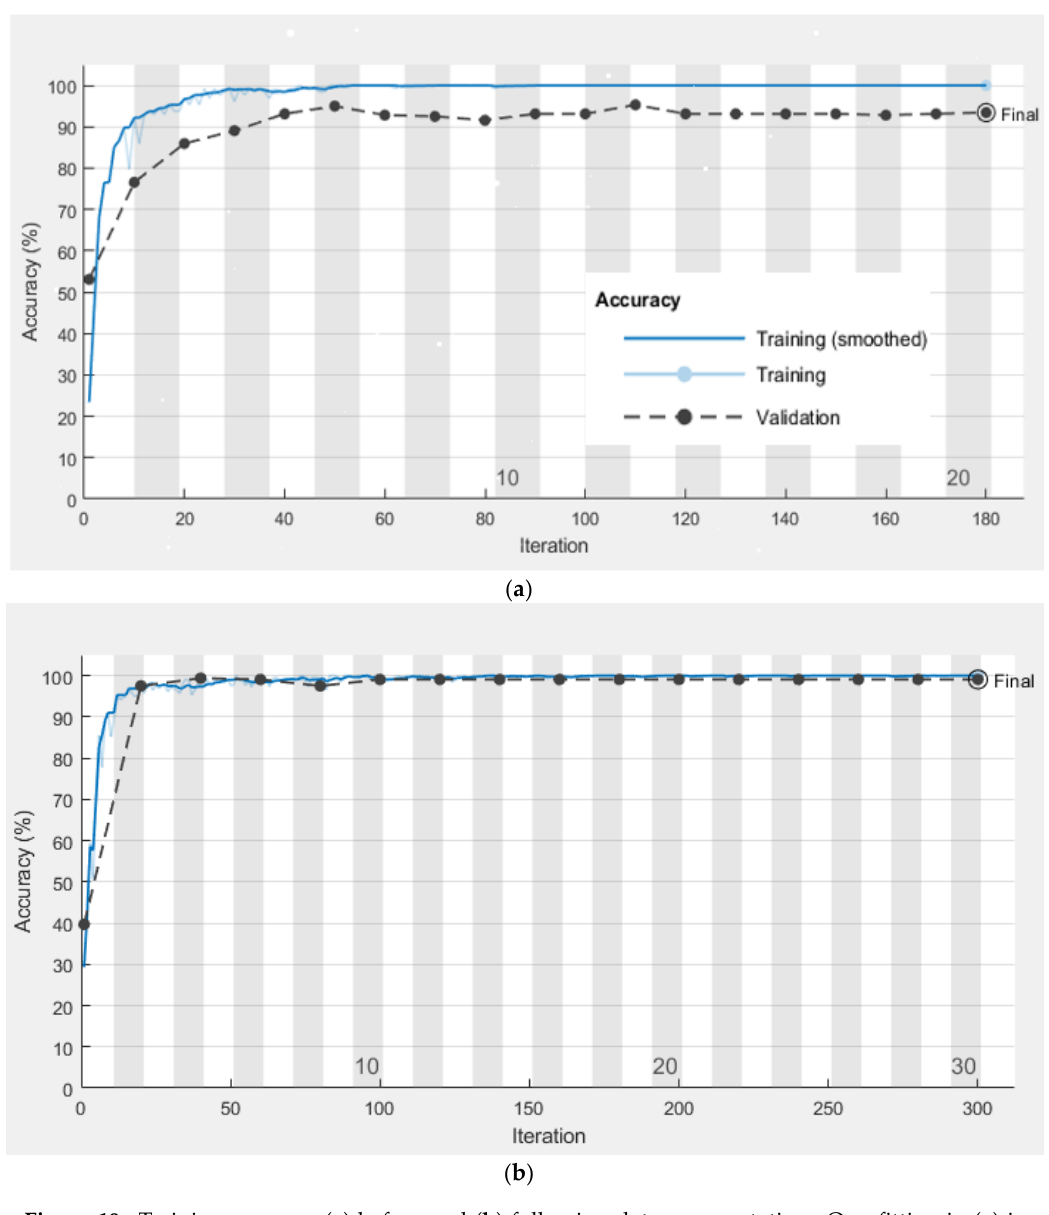
Figure 19. Training progress ( a ) before and ( b ) following data augmentation. Overfitting in ( a ) is evident through high variation between training and validation accuracy.